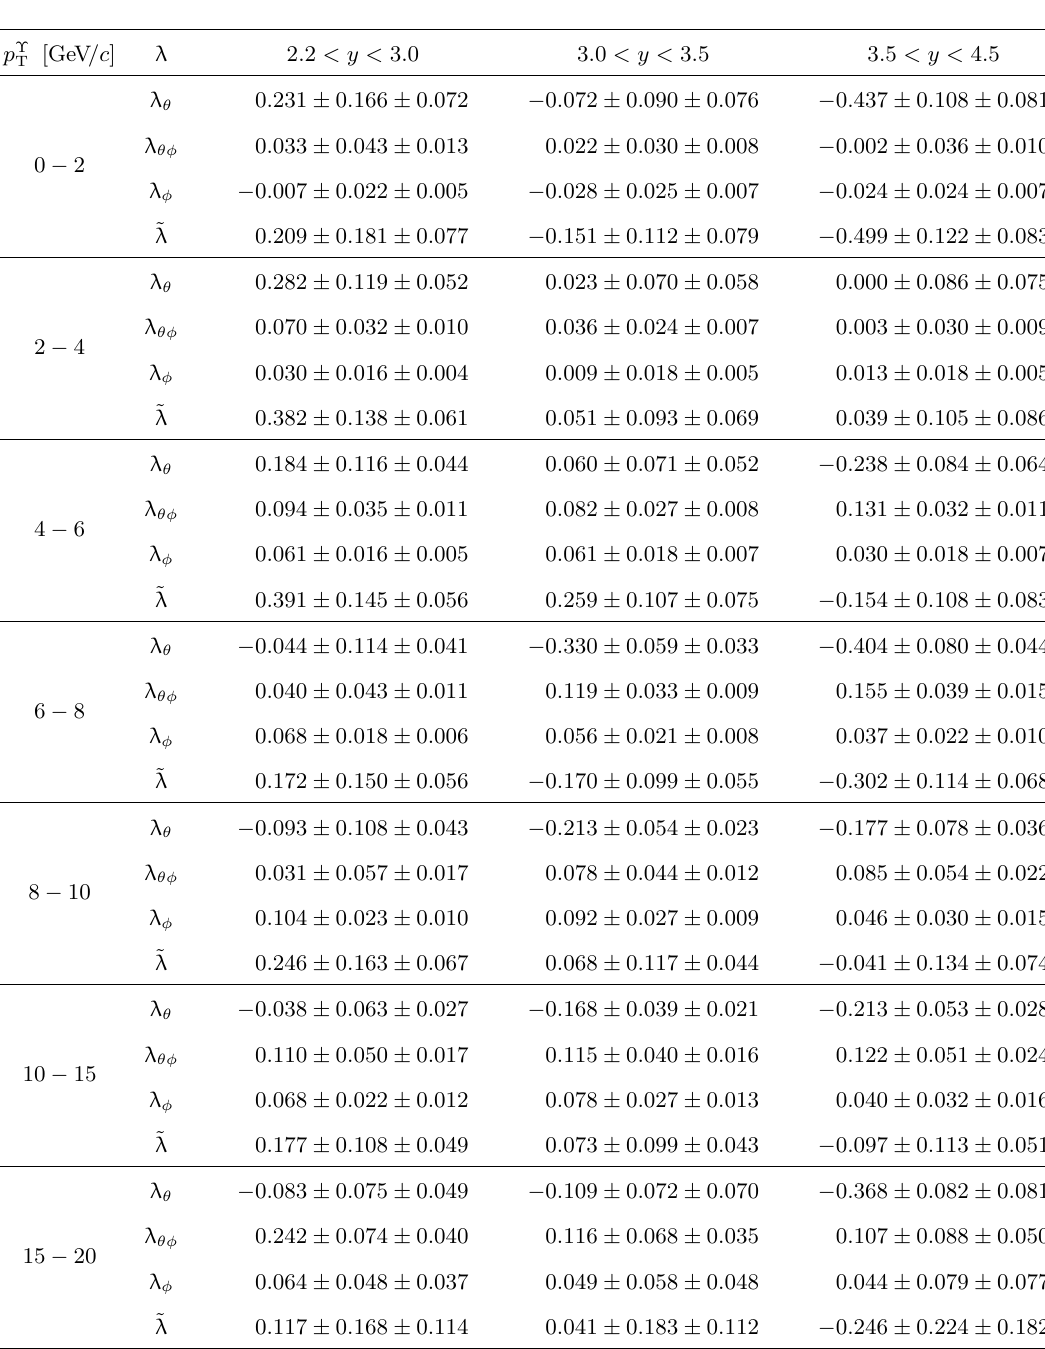
Table 23 . Values of (cid:21) (cid:18) , (cid:21) (cid:18)(cid:30) , (cid:21) (cid:30) and ~ (cid:21) measured in the CS frame for the (cid:7)(3S) produced at p s = 8 TeV. The (cid:12)rst uncertainty is statistical and the second systematic.